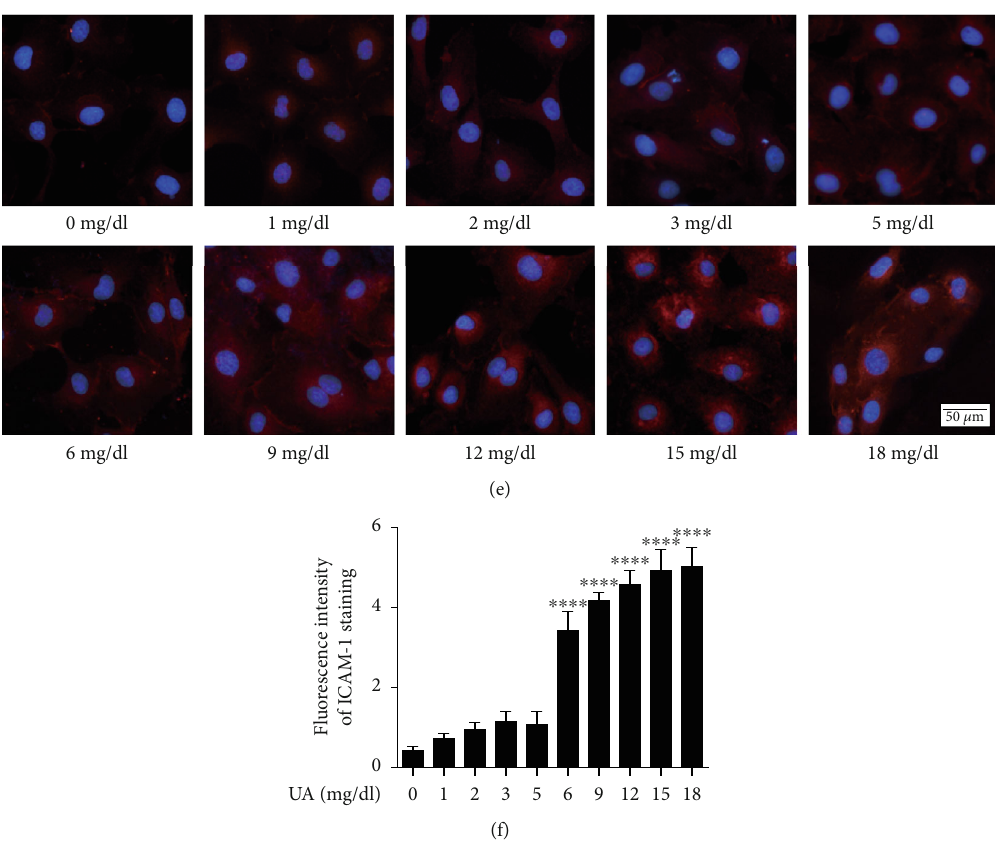
Figure 2: Changes of HUVECs under the stimulation of di ff erent concentrations of uric acid HUVECs were stimulated with 0, 1, 2, 3, 5, 6, 9, 12, 15, and 18 mg/dL uric acid for 24 h. Changes in (a) cell morphology in di ff erent groups. Scale bar = 200 μ m. (b) Cell survival rate in di ff erent groups by CCK-8 assay. (c, d) DHE immuno fl uorescence image and densitometry analysis of immuno fl uorescent intensity of DHE. Scale bar = 50 μ m. (e, f) ICAM1 immuno fl uorescence image and densitometry analysis of immuno fl uorescent intensity of ICAM1. Scale bar = 50 μ m. DHE: dihydroethidium; HUVECs: human umbilical vein endothelial cells. The statistical analyses were done using GraphPad Prism V-7.0 software. Data are expressed as the mean ± standarddeviation ( n = 3 ). One-way ANOVA was used in statistical analyses ( n = 3 /group). ∗ P < 0 : 05 , ∗∗ P < 0 : 01 , ∗∗∗ P < 0 : 001 , and ∗∗∗∗ P < 0 : 0001 versus the